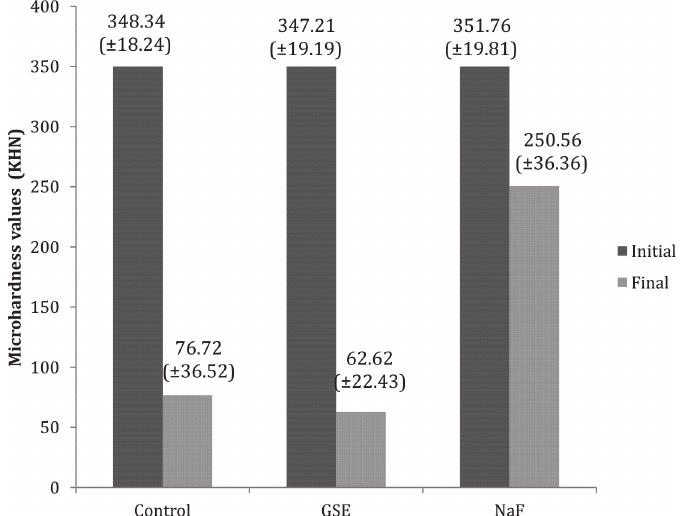
Figure 2- Means and standard deviation of enamel surface hardness (KHN) according to the different groups before and after treatment with fluorides and grape seed